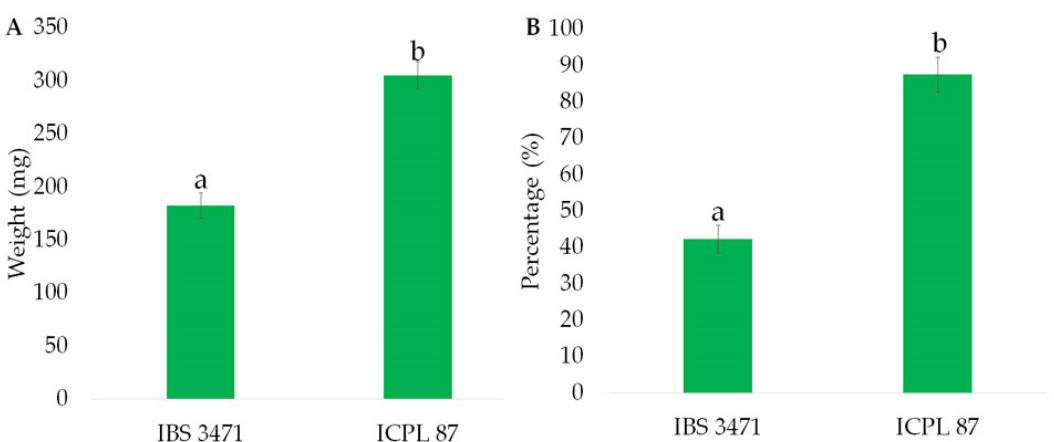
Figure 3. Average larval weight and percentage of pupation when H. armigera larvae were fed on C. scarabaeoides (IBS 3471) and C. cajan (ICPL 87) based artificial diets. ( A ) Average larval weight (mg) by day five. ( B ) Percentage of pupated H. armigera larvae by day 11. Values labelled with different letters are significantly different at p < 0.01 ( t -test). All data are means ± standard errors ( n = 64).